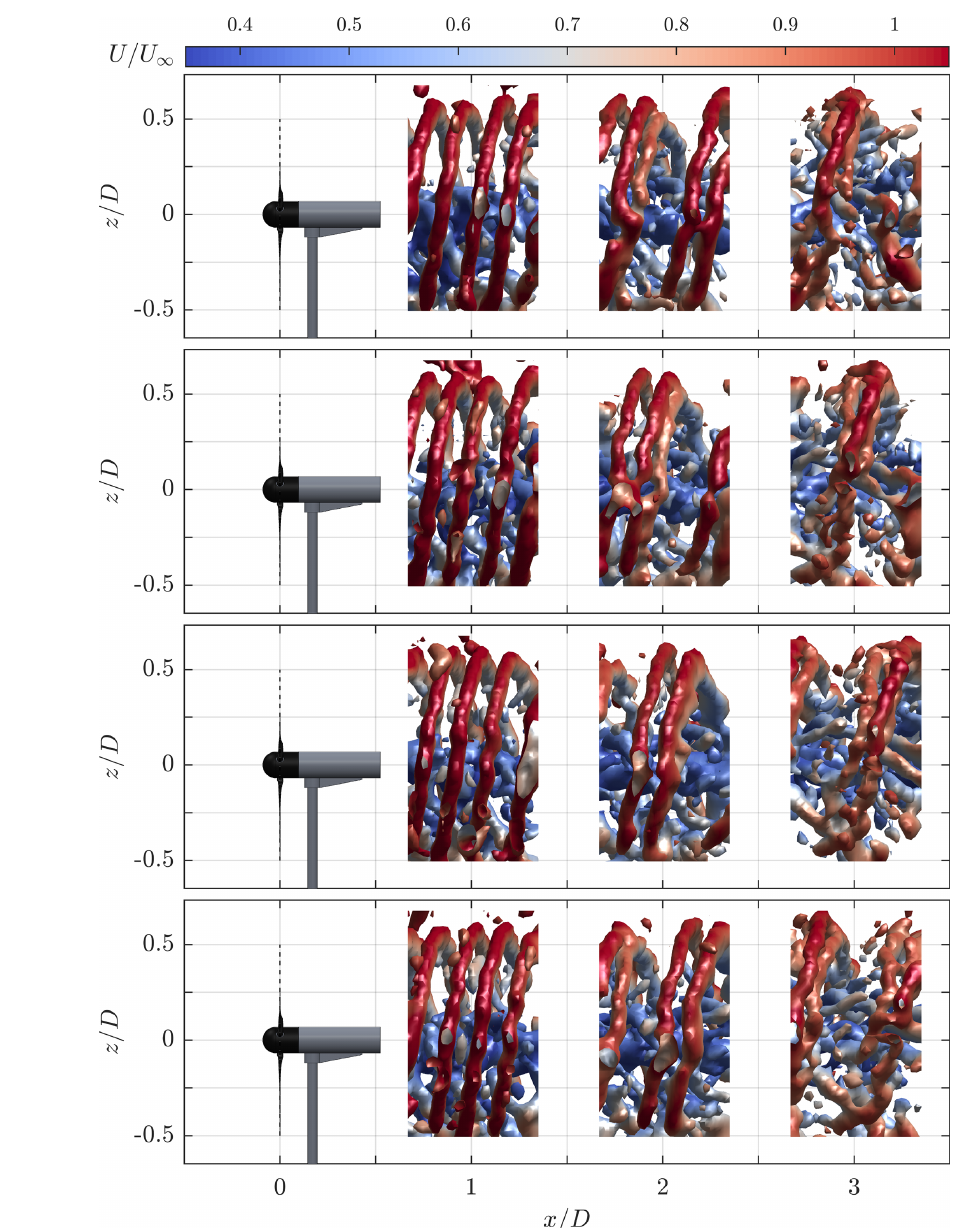
Figure 13. Isosurfaces of the instantaneous normalized Q criterion ( QD 2 /U 2 ∞ = 1) visualizing the blade tip vortices for baseline opera- tion. The different snapshots are separated by (cid:49)t = 0 . 02s. The colors of the isosurfaces correspond to the normalized streamwise velocity